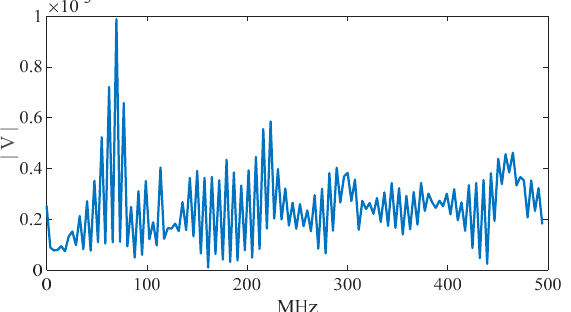
Figure 3. dsPIC33EP512MC202 frequency domain EM leak (adapted from [10]).